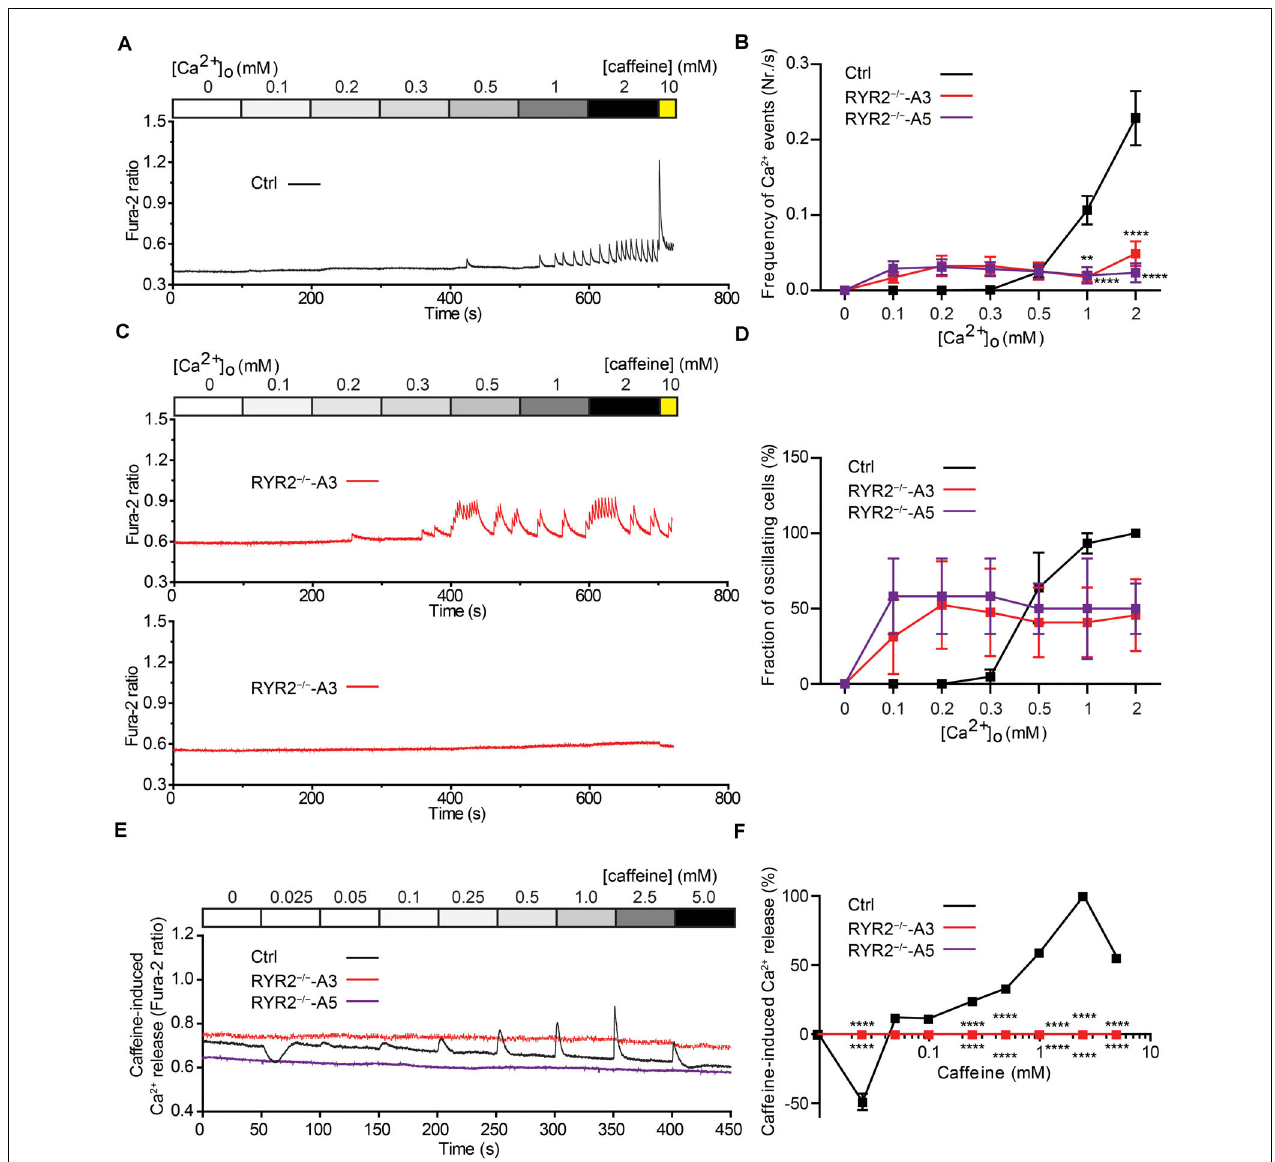
FIGURE 6 | Sensitivity of Ctrl- and RYR2 − / − -iPSC-CMs to extracellular calcium and caffeine. (A,B) Cytosolic Ca 2 + dynamics in Ctrl-iPSC-CMs (A) and A3 RYR2 − / − -iPSC-CMs (B) perfused with increasing concentrations of extracellular Ca 2 + ([Ca 2 + ] o ). Cytosolic Ca 2 + dynamics in A3 RYR2 − / − -iPSC-CMs (B) were inconsistent from cell to cell. (C) Frequency of Ca 2 + events detected in Ctrl- and RYR2 − / − -iPSC-CMs under different [Ca 2 + ] o . (D) Percentage of CMs displaying Ca 2 + events under different [Ca 2 + ] o concentrations among the three groups (Ctrl: n = 20 cells from four differentiation experiments; A3 RYR2 − / − : n = 15 cells from three differentiation experiments; A5 RYR2 − / − : n = 12 cells from two differentiation experiments). (E) Representative traces of caffeine-induced Ca 2 + release in Ctrl- and RYR2 − / − -iPSC-CMs. (F) Relationship between Ca 2 + release and caffeine concentration in CMs from the two groups. The amplitude of each caffeine-induced Ca 2 + release was normalized to the maximum peak for each experiment (Ctrl: n = 20 cells from four differentiation experiments; A3 RYR2 − / − : n = 6 cells from two differentiation experiments; A5 RYR2 − / − : n = 6 cells from two differentiation experiments). ** P < 0.01, **** P < 0.0001 RYR2 − / − vs. Ctrl by the two-way ANOVA with the Sidak’s multiple comparison